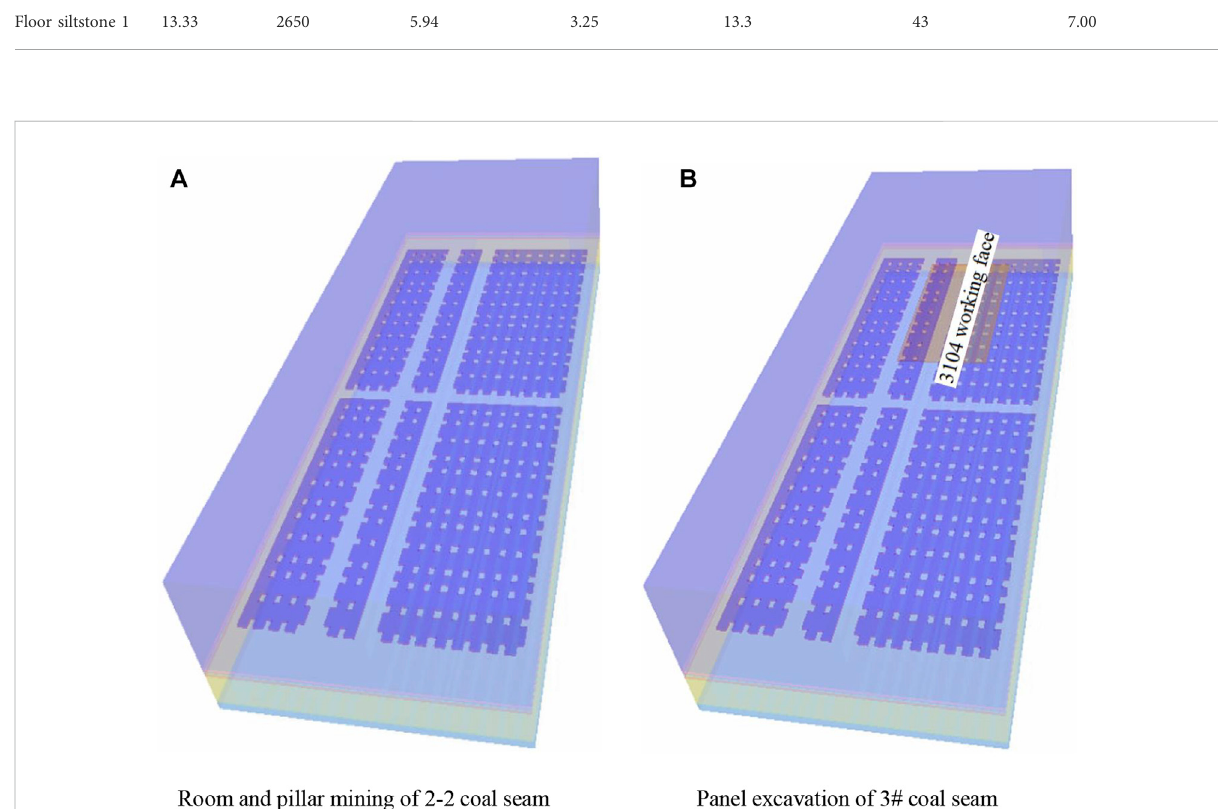
FIGURE 6 Mining plan of room and pillar mining. (A) Room and pillar mining of 2-2 coal seam (B) Panel excavation of 3# coal seam